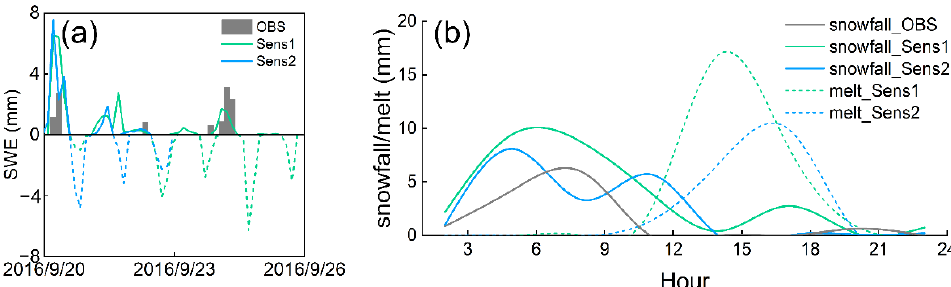
Figure 3. ( a ) Observed and modeled three-hourly SWE in late September over the Parlung No. 4 Glacier (solid line indicates snow accumulation and the dashed line indicates snow melt). ( b ) Corresponding accumulated diurnal variation of snowfall and snow melt estimates.